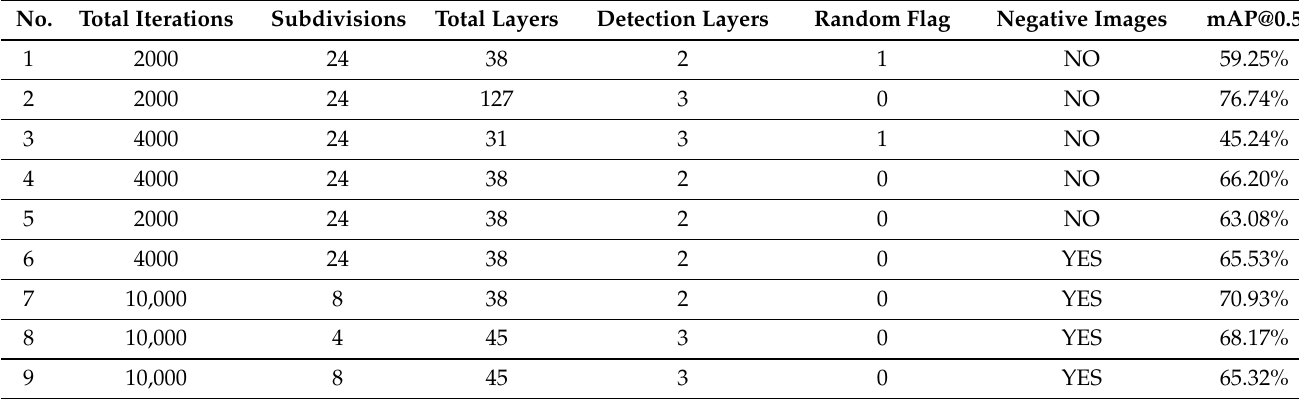
Table 1. Configurations of YOLOv4-tiny used and mAP@0.5IoU obtained.